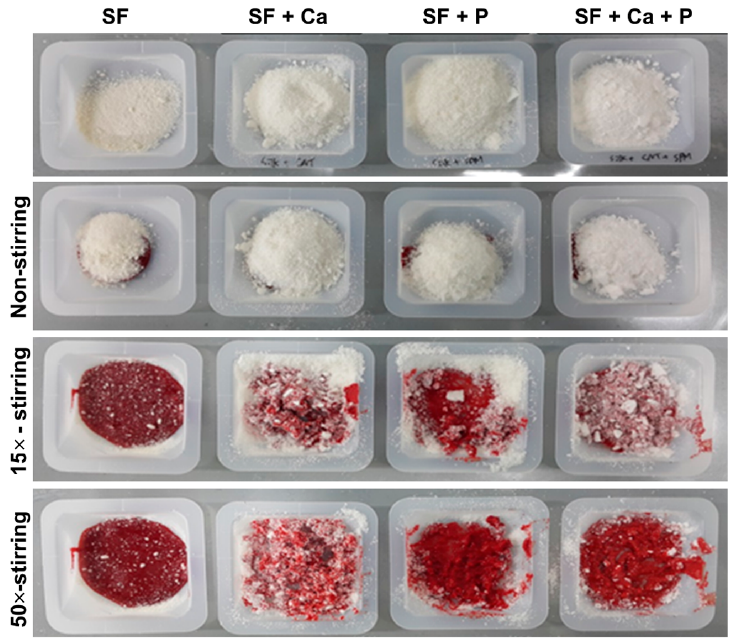
Figure 2. Evaluation of the in vitro blood coagulation effect of the SF-based powder. SF powders containing calcium (SF + Ca) and phosphoric acid (SF + P) exhibited improved blood coagulation when it reacted with them. Unpublished data.